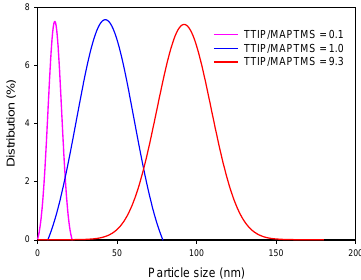
Figure 1. The dynamic light scatter data plot of Ti–O–Si-organic hybrid sols with several titanium(IV) isopropoxide/methacryloxypropyltrimethoxysilane (TTIP/MAPTMS) ratios.